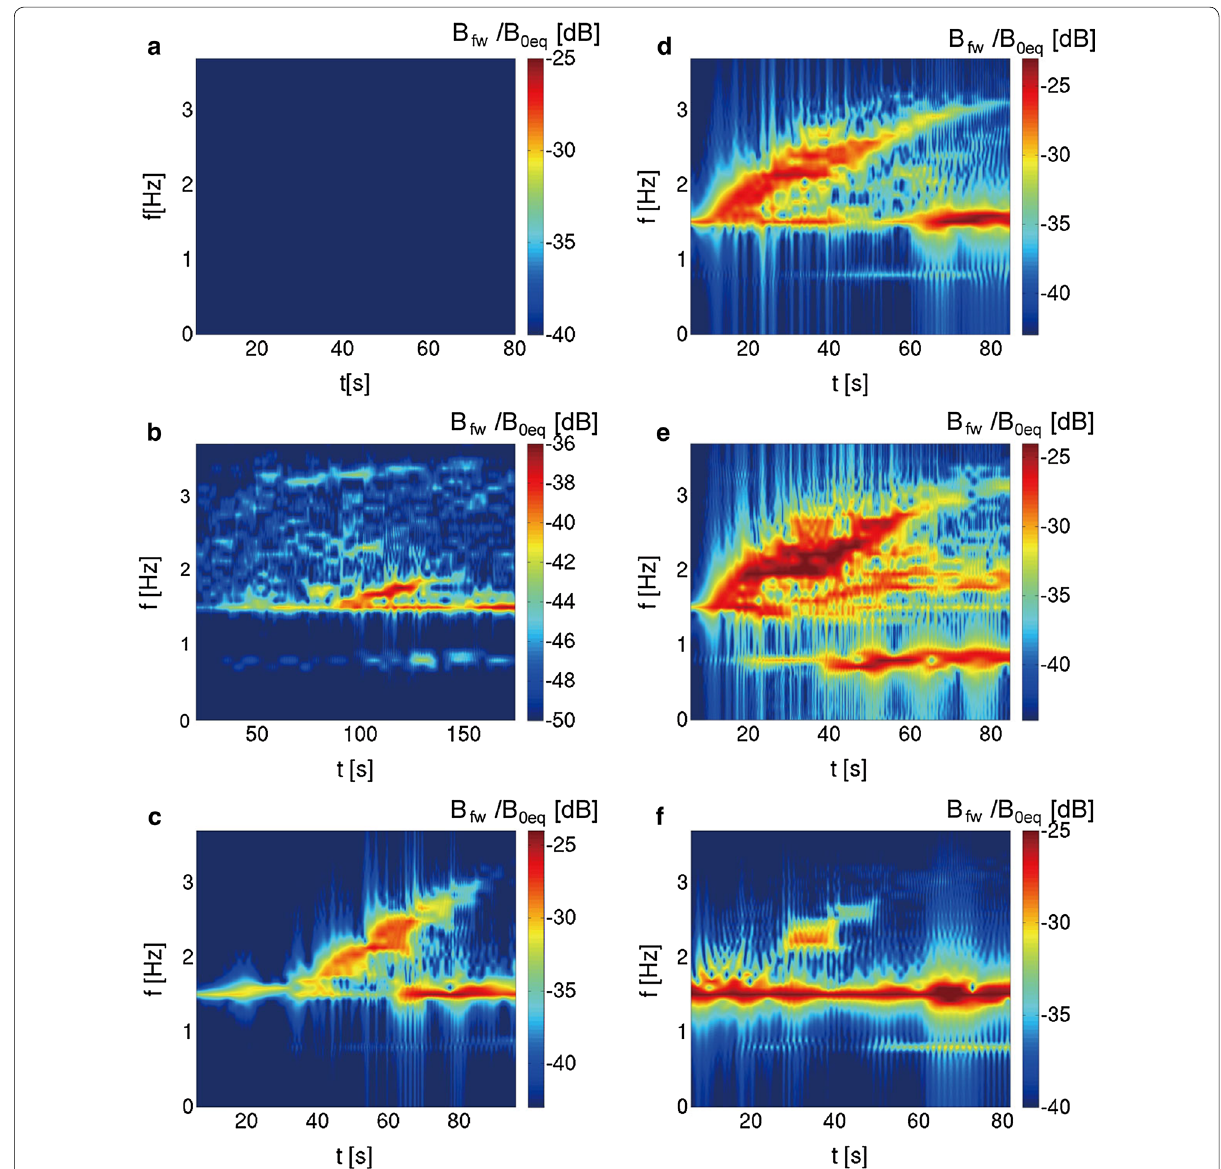
Fig. 10 Dynamic spectra of forward propagating waves with different parameters described in Table